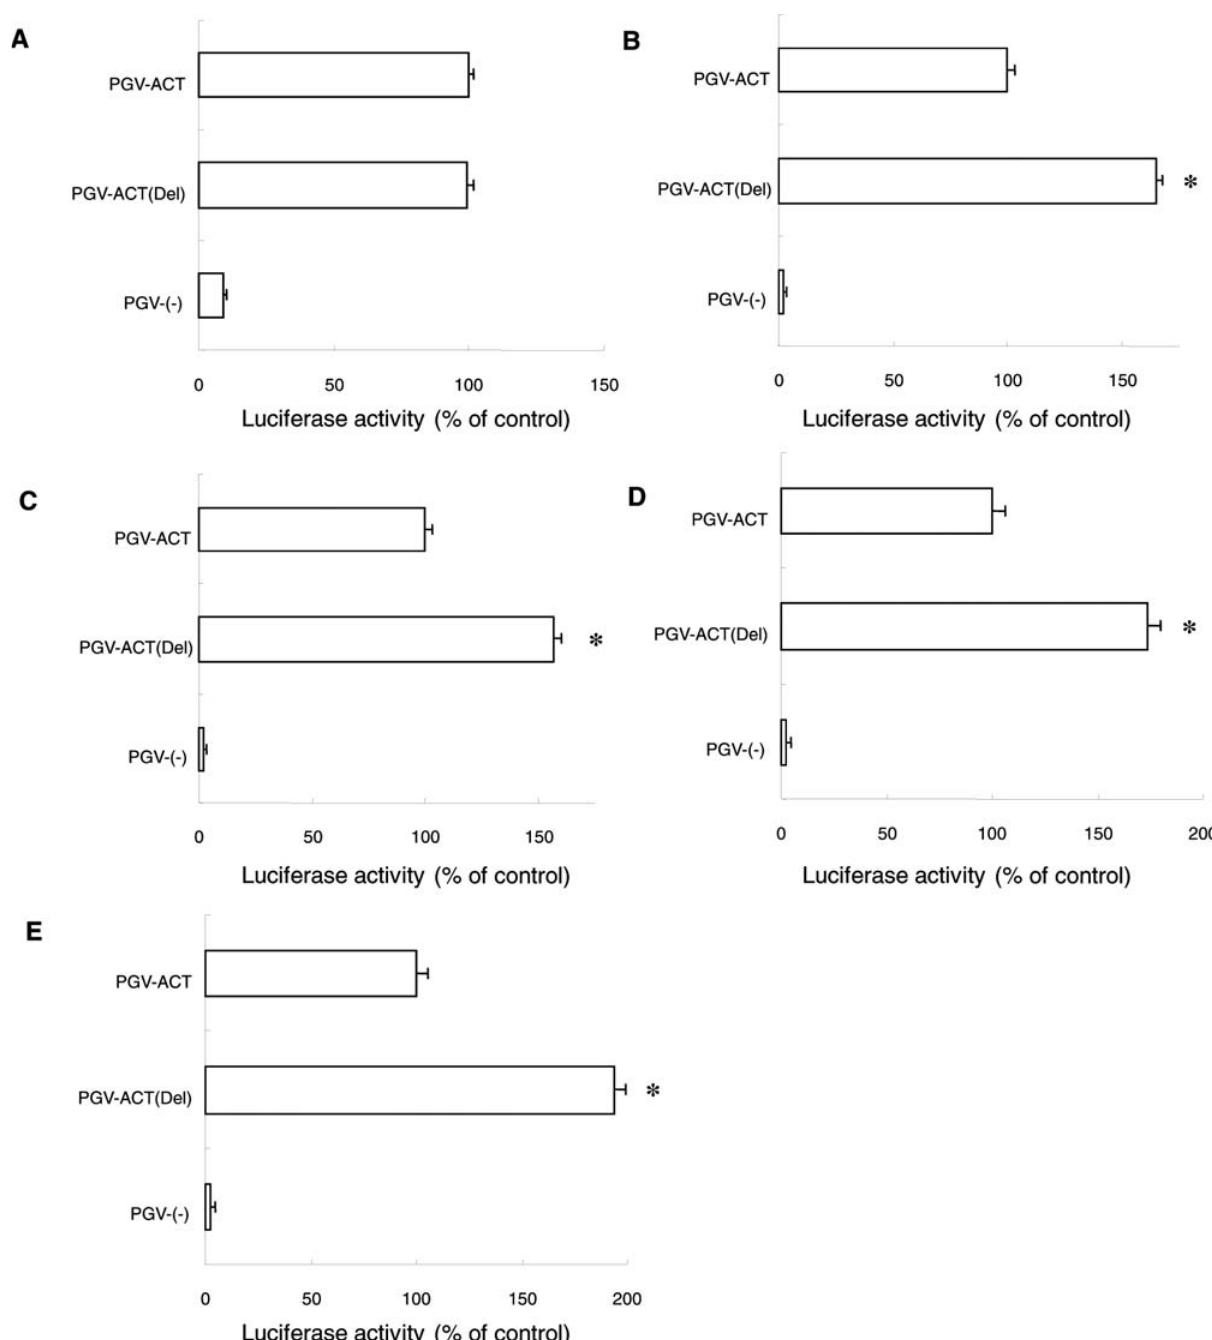
Figure S2 - Effects of the deletion of a region in the MDM2 promoter on luciferase activity in Colo320DM, U251, T98G, YMB-1, and HeLa cells. Colo320DM (A), U251 (B), T98G (C), YMB-1 (D), and HeLa (E) cells were transfected with the indicated vector constructs of PGV-ACT (containing nucleotideAatposition-628,Cat-466,andTat-215),PGV-ACT(Del)(nucleotidesat-725to-311deleted),andPGV-(-).Thetransfectedcellswerecul- tured for 24 h, and luciferase activity was determined. Data are shown as percentages of values obtained from the PGV-ACT transfectants and are ex- pressed as the mean (cid:5) SD (n = 3). *: Significant difference compared with the PGV-ACT